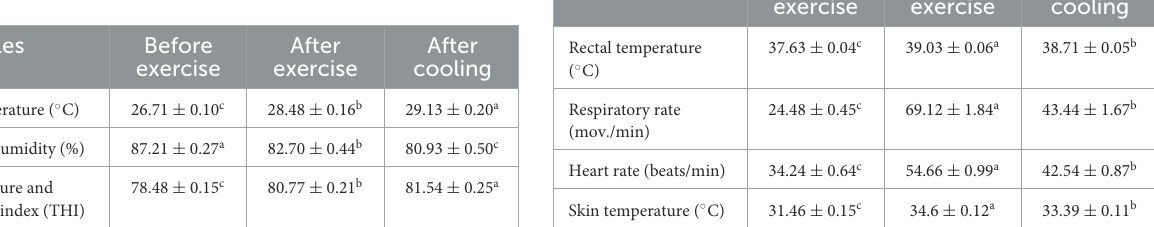
TABLE 1 Means and standard error of the variables and climate index were measured at three evaluation times for horses: before exercise, after exercise and after cooling down, in the experimental area, in Ananindeua, Pará.